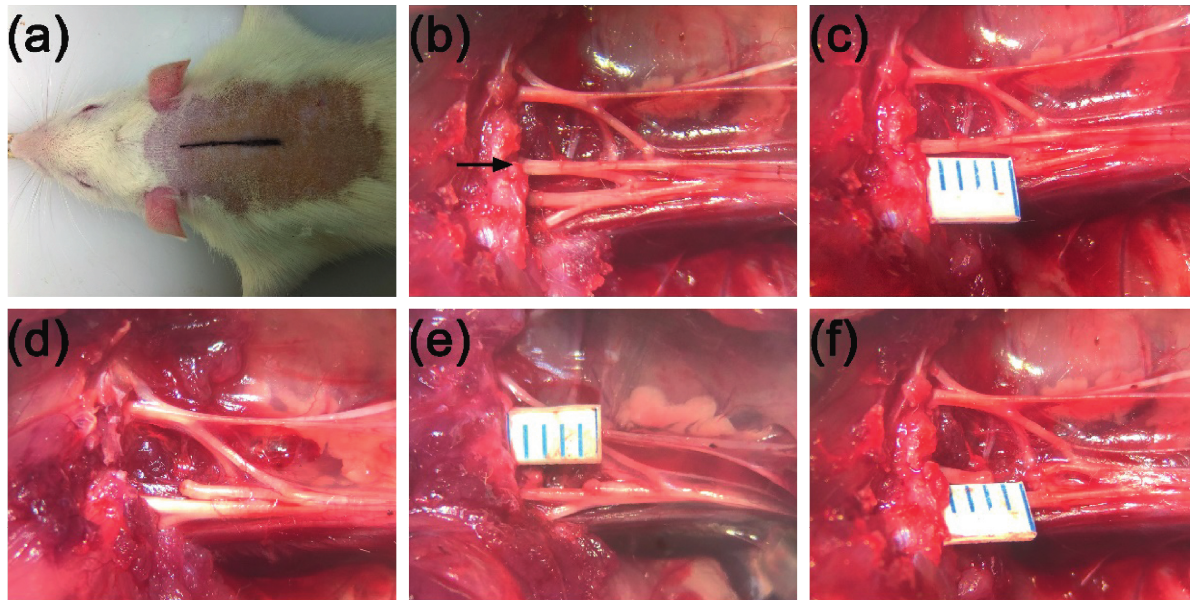
Figure 2: C7 neurotomy procedure. (a) A midline incision on the back of the neck is made. (b) The C5-T1 brachial plexus fully exposed (the black arrow indicates the C7 nerve root). (c) The C7 nerve measured distally relative to the intervertebral foramen (each marking � 1 mm). (d–f) The C7 nerve is resected at 0, 2, or 4mm according to the subgroup. After neurotomy, the C7 nerve stumps are slightly